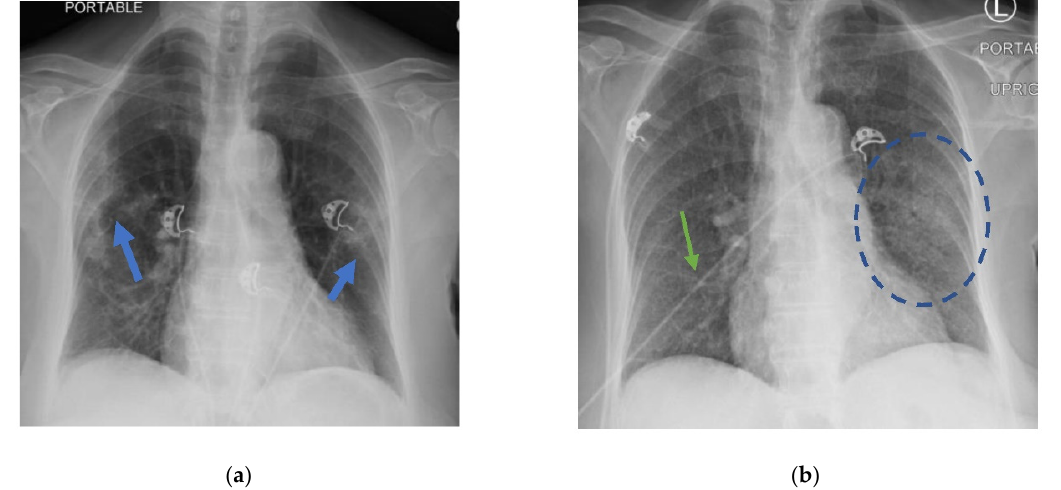
Figure 1. ( a ) Chest X-ray with multifocal ground glass infiltrates (blue arrows) during active COVID-19 infection; ( b ) chest X-ray 3 months after with resolution of prior patchy bilateral infiltrates with prominent interstitial markings (green arrow) unchanged from prior chest X-ray and new left mid-lung zone infiltrate (blue circle).